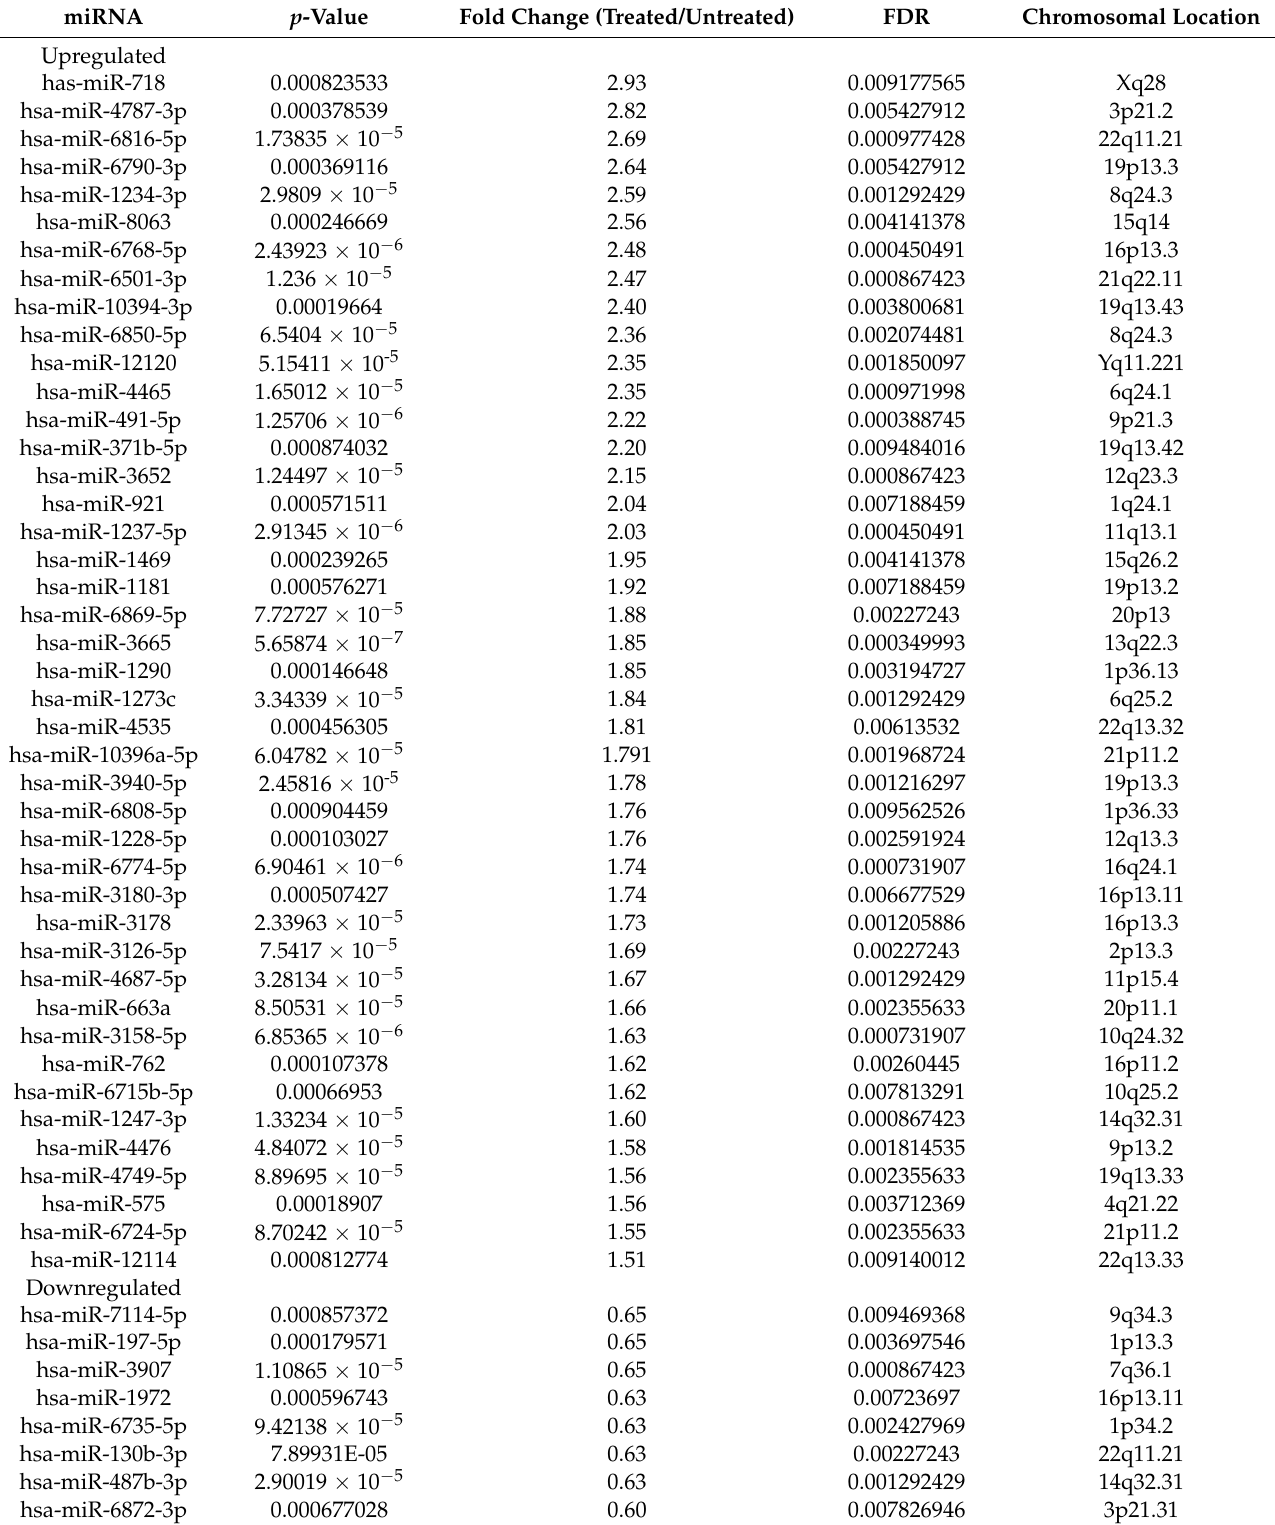
Table 1. Statistical results and chromosomal locations of miRNAs that exhibited a fold change (FC) > 1.5, FC < 0.67, or p < 0.001 in HCC Huh-7SR cells treated with lenvatinib when compared with untreated cells. miRNA p -Value Chromosomal